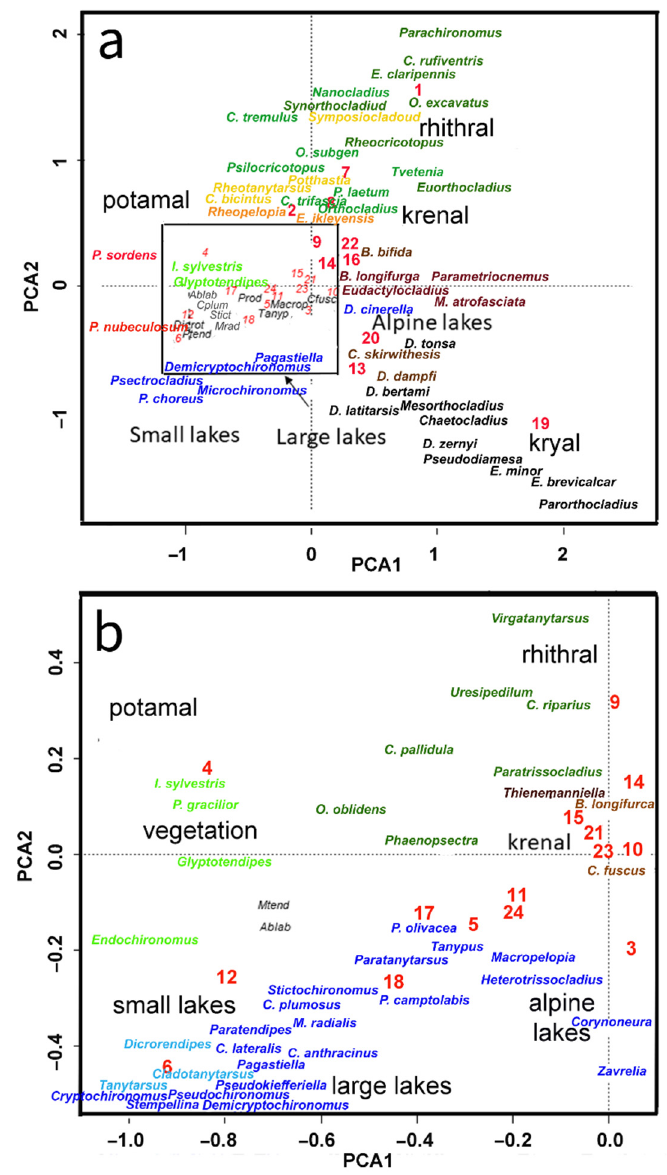
Figure 11. Results of PCA analysis: ( a ) PCA map of codebooks; ( b ) detail of map, biplot of morphotaxa, and codebook cells according to the first two axes; morphotaxa labels are coloured according to supposed preferred habitat. Grey, kryal; dark brown, krenal; green, vegetation; dark green, rhithral; dark yellow, epipotamal; red, potamal; blue, lakes.